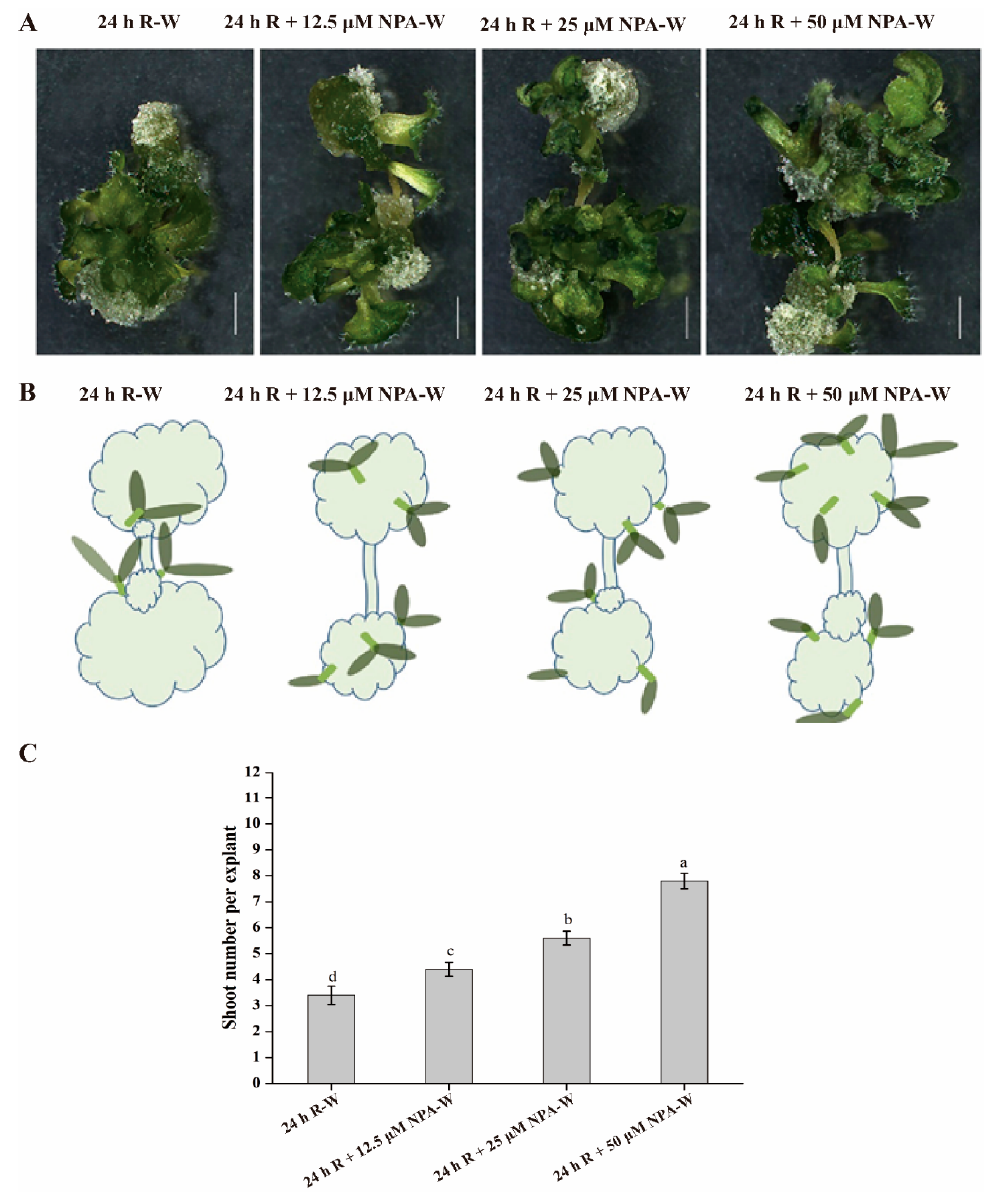
Figure 3. E ff ects of 1-N-naphthylphtalamic acid (NPA) treatment on average shoot number per explant, the percent explant with shoots and shoot distribution pattern. ( A ) Shoot number and distribution pattern under di ff erent treatments. Compared with the shoot morphology under the 24 h R-W treatment, di ff erent concentrations of NPA both increased the average shoot number and distributed the shoot distribution pattern. ( B ) Model for shoot distribution pattern under di ff erent treatments. Shoots were centralized to the middle location under the 24 h R-W treatment, NPA treatments caused the wide distribution of shoots. ( C ) E ff ects of NPA concentration on average shoot number per explant. With the increase in NPA concentration, the average shoot number per explant was also increased. The 24 h R-W treatment refers to early 24 h red light shifting to 6 days white light in the CIM, followed by white light treatment in the SIM. The 24 h R + 12.5 µ M NPA-W, 24 h R + 25 µ M NPA-W, or 24 h R + 50 µ M NPA-W treatments refer to: 24 h of red light treatment on CIM containing 12.5, 25, or 50 µ M NPA after root excision, then transfer to white light in the CIM and SIM. Error bars indicate the standard deviation from three independent experiments, each containing 120 root segments of Arabidopsis thaliana . The least significant di ff erence method (LSD) was used for the significance test ( p < 0.05); Di ff erent lowercase letters represent statistical di ff erences in pairwise comparisons between LSD test groups ( p <